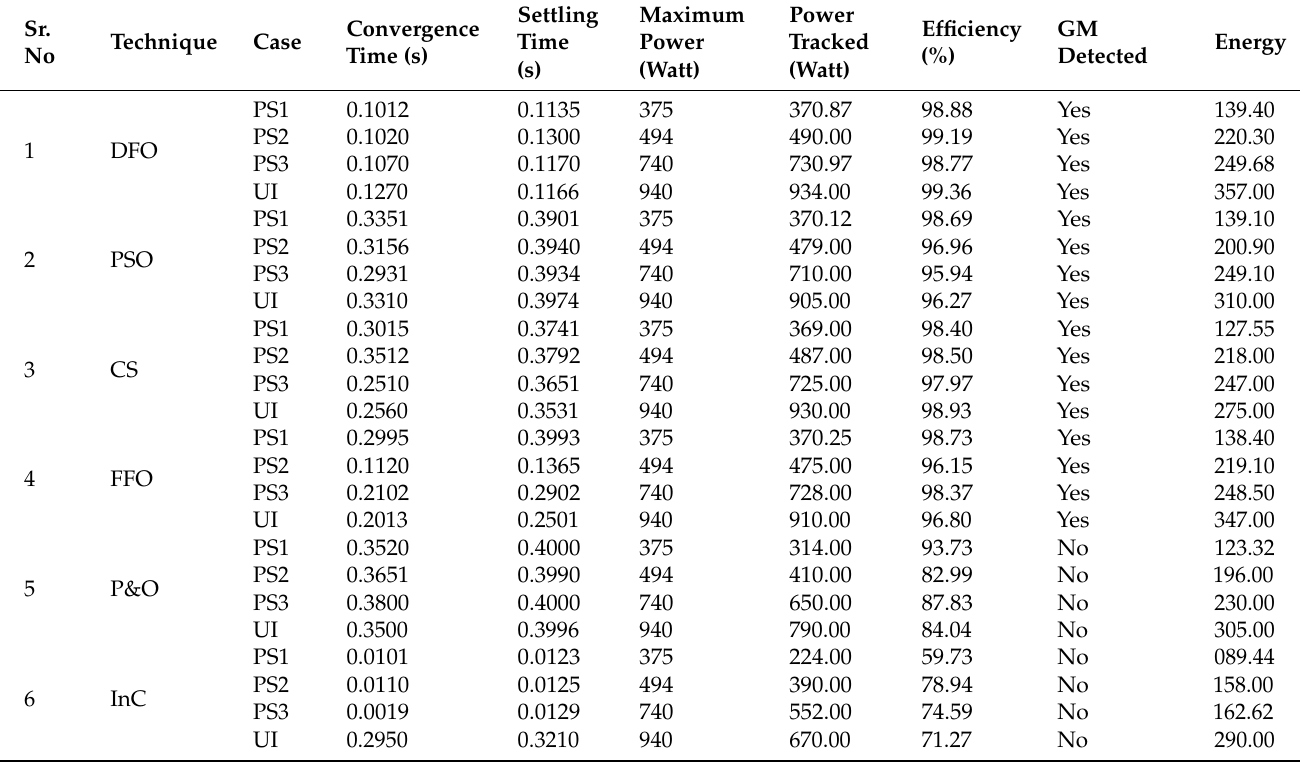
Table 4. Comparative analysis of DFO with PSO, CS, FFO, P&O AND InC MPPT algorithm for UI and PS conditions for centralized PV system.